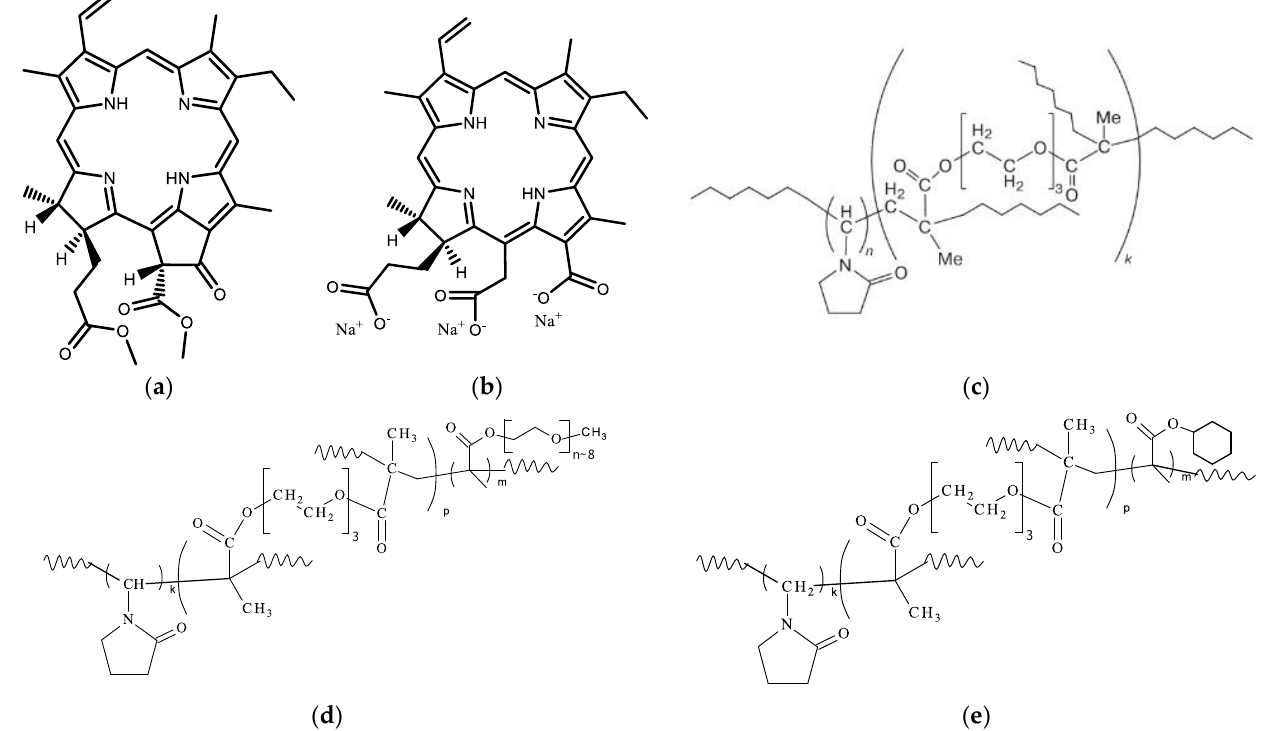
Figure 1. Chemical structure of methylpheophorbide a , MPP ( a ), reference PS chlorin e 6 sodium salt (Ce6), ( b ) and copolymers: VP−TEGDM (CPL1) ( c ), VP−PEGMEM−TEGDM (CPL3, CPL5) ( d ), VP-CHM-TEGDM (CPL12) ( e ).